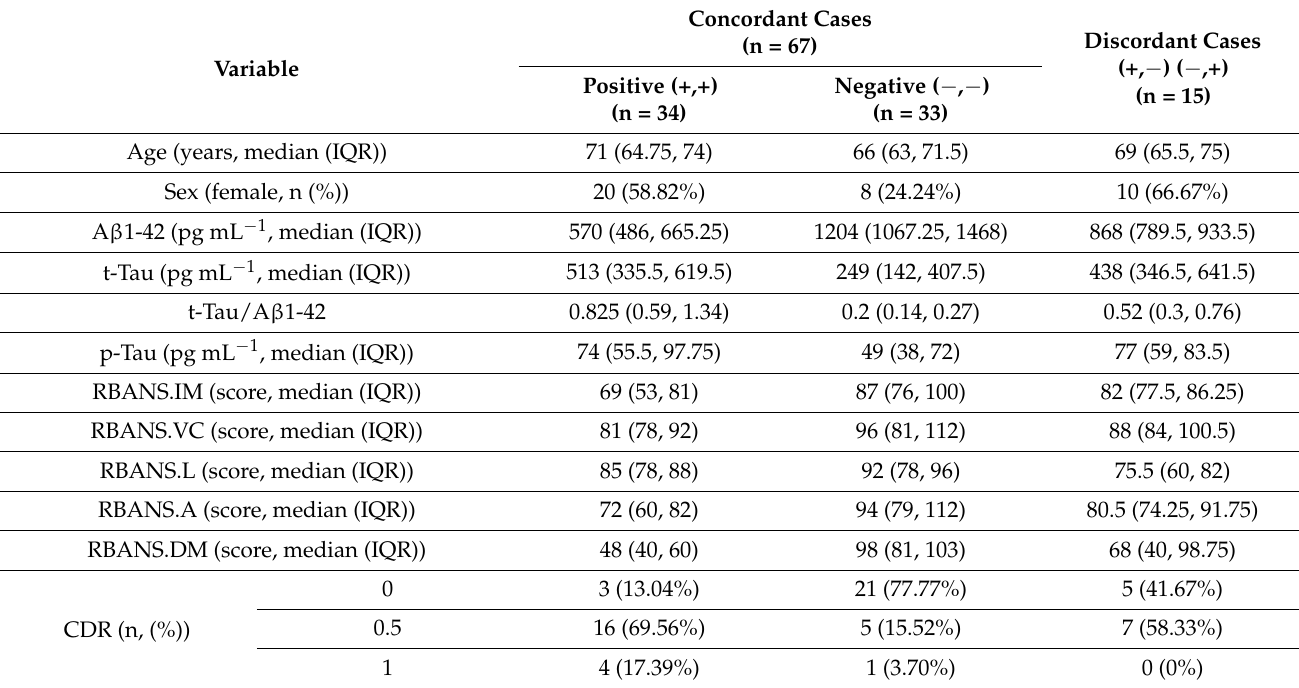
Table 1. Demographic and clinical characteristics of